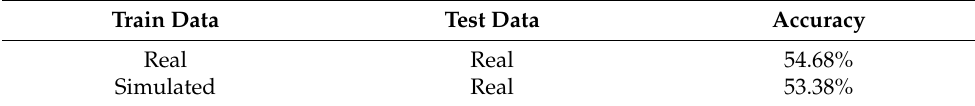
Table 7. Cross-validation for testing the real Video-SAR